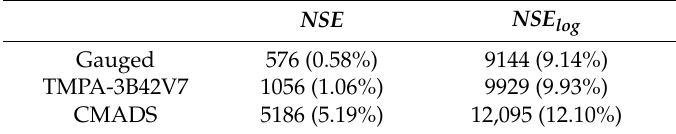
Table 9. Number (percentage) of behavioral parameter sets for the IHACRES model.